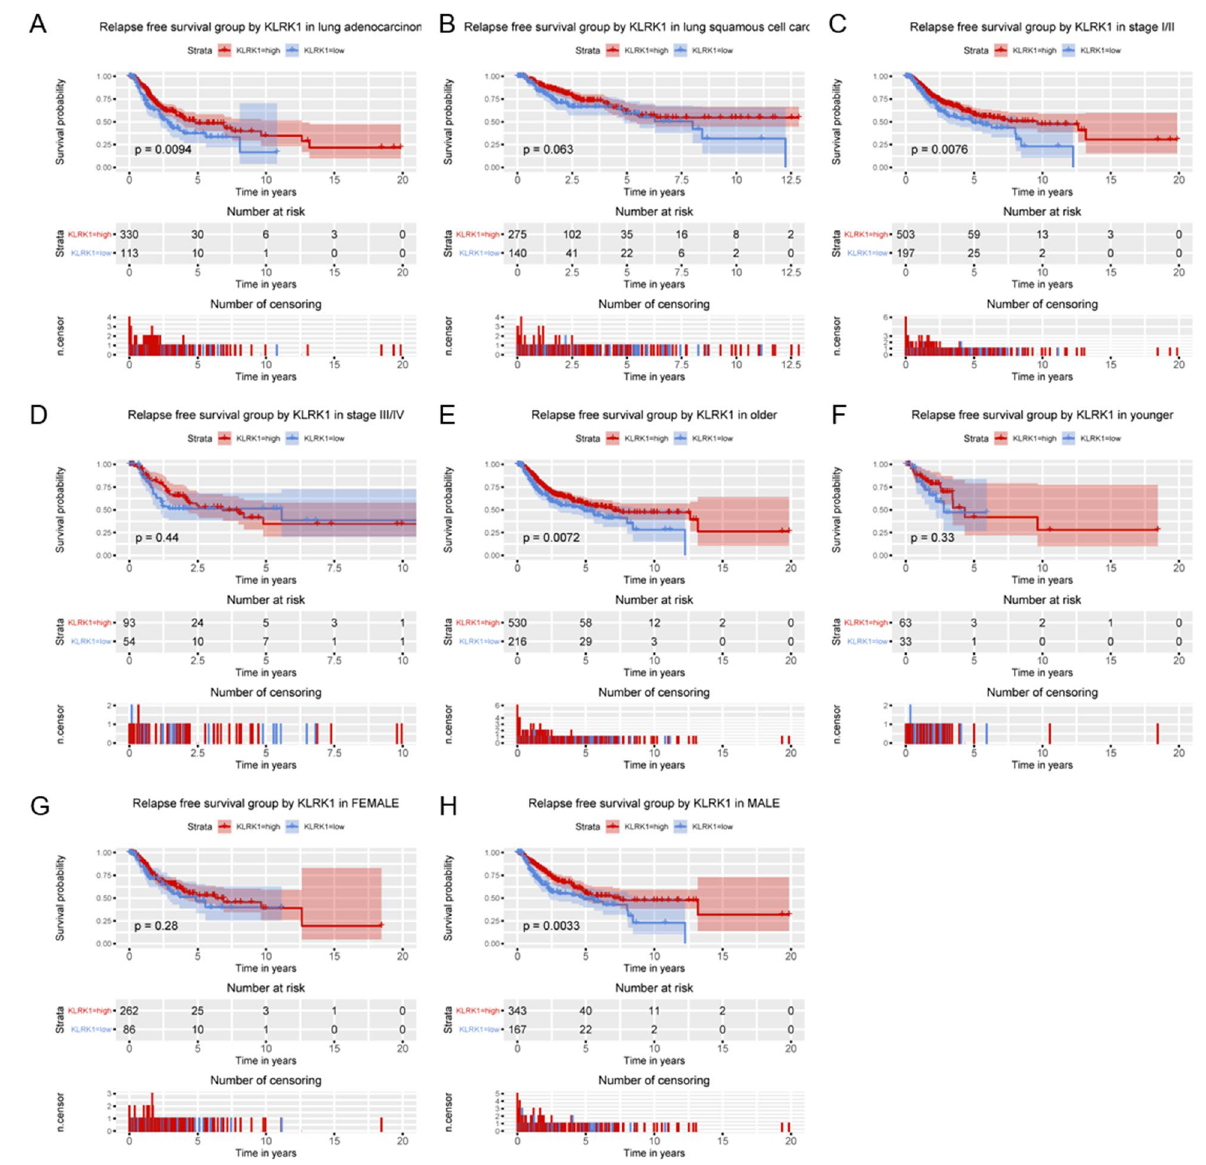
Figure 8. Relationship of KLRK1 expression with relapse free survival in all patients with lung cancer in ( A ) lung adenocarcinoma, ( B ) lung squamous cell carcinoma, ( C ) stage I/II, ( D ) stage III/IV, ( E ) older patients, ( F ) younger patients, ( G ) female and ( H )